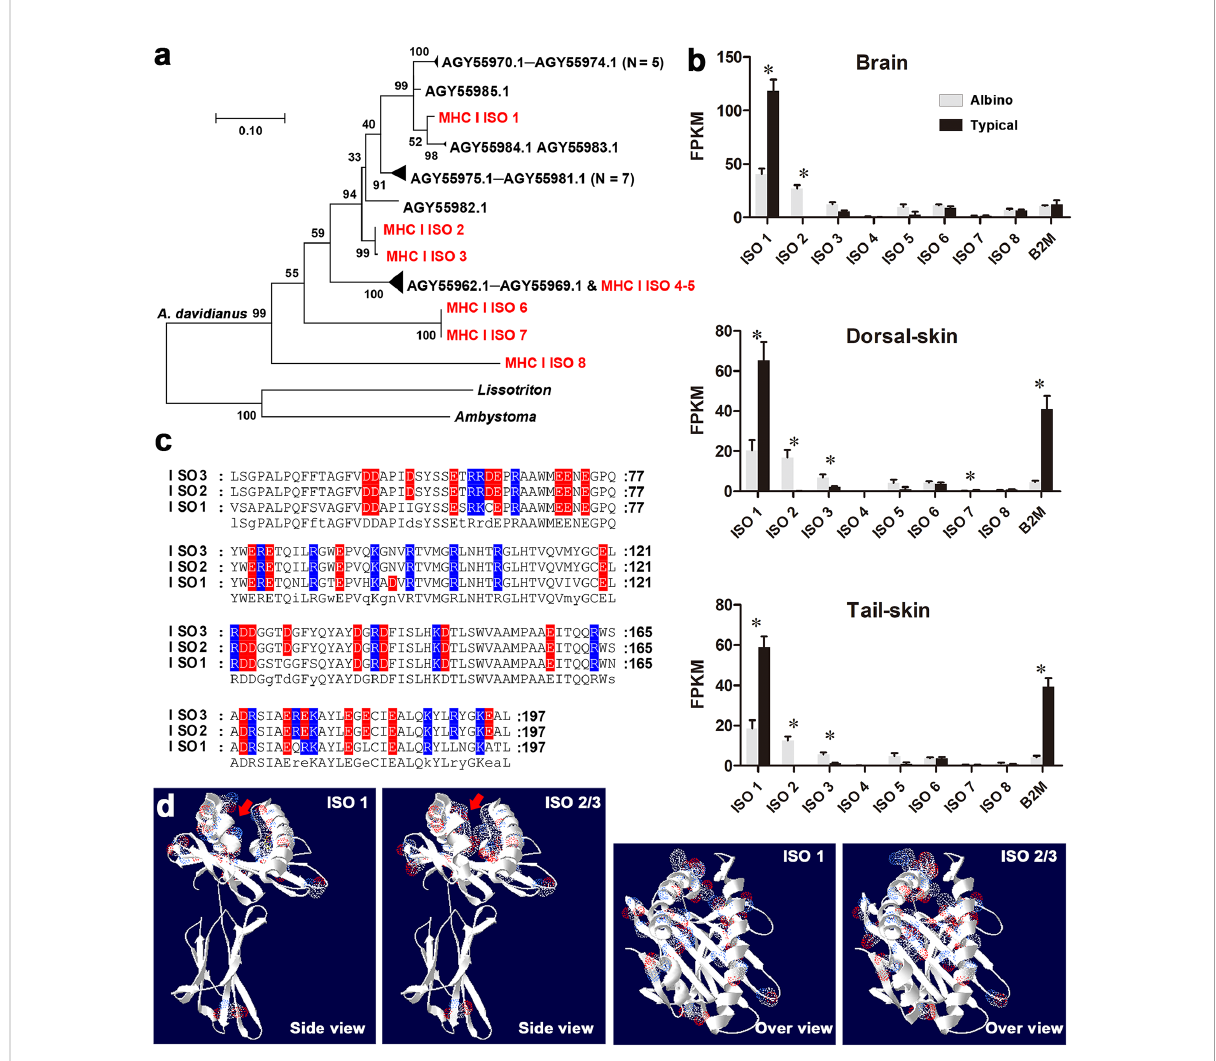
FIGURE 3 Sequence and expression analysis of MHC class I genes. (A) Maximum likelihood tree for MHC class I genes (see the sequences in Table S2). Red items denote MHC class I isotypes identi fi ed in this study; black items denote the known MHC class I genes of A davidianus and closely related species. (B) Transcriptional levels of MHC class I isotypes and B2M. Asterisks denote signi fi cant differences between groups (at a threshold of p < 0.05, Student ’ s t test). (C) Amino acid substitutions in the antigen- binding regions of MHC class I isotypes. Red and blue characters represent negative and positive charges. (D) 3D structure of MHC class I isotypes. The sites of amino acid substitution are highlighted by electron clouds (blue: positive residues; red: negative residues). Red arrows denote antigen- binding pockets. Note the reduced space and increased charges in the antigen- binding pockets of isotypes 2 and